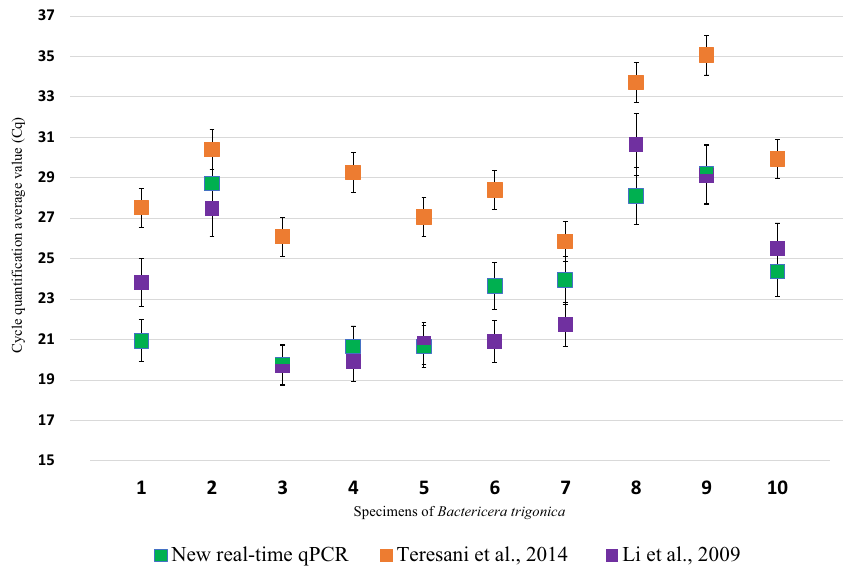
Figure 3. Relative sensitivity (average of C q values) of the new real-time qPCR protocol designed in this study, performed with direct samples of ten specimens of Bactericera trigonica infected with ‘ Candidatus Liberibacter solanacearum’, in comparison with real-time PCRsprotocols described by Teresani et al. 25 and Li et al. 54